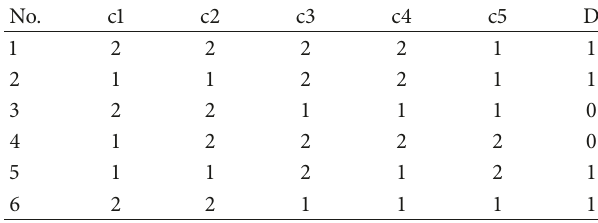
Table 3: Discrete results based on information entropy.